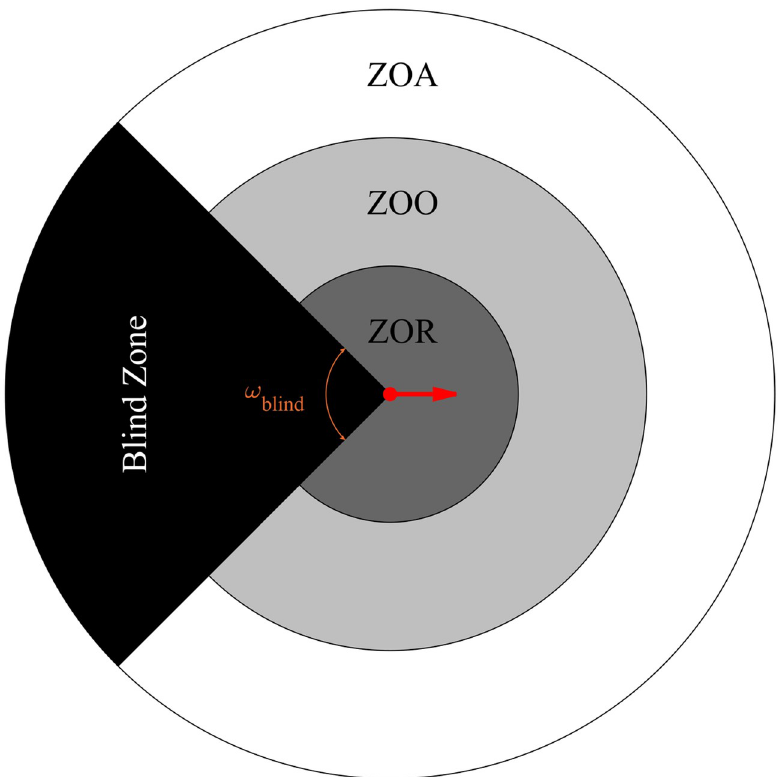
Fig 1. In the zonal model developed in [13], a focal individual (located at the center of the diagram, moving to the right in the direction indicated by the red arrow) is assumed to adjust its direction of motion to: Move away from group members in the dark gray zone (the Zone of Repulsion (ZOR)) to avoid collision, align its direction of motion with those in the light gray zone (the Zone of Orientation (ZOO)), and move towards individuals within the white circle (the Zone of Attraction (ZOA)) to remain in contact with the group. The individual will not adjust its motion in response to neighbours located in its blind zone (indicated by the black wedge). ω blind is the blind angle. The radius of the circle bounding the ZOR is r , the radius of the circle bounding the ZOO is r and the radius of the r o circle bounding the ZOA is r . These circles are a